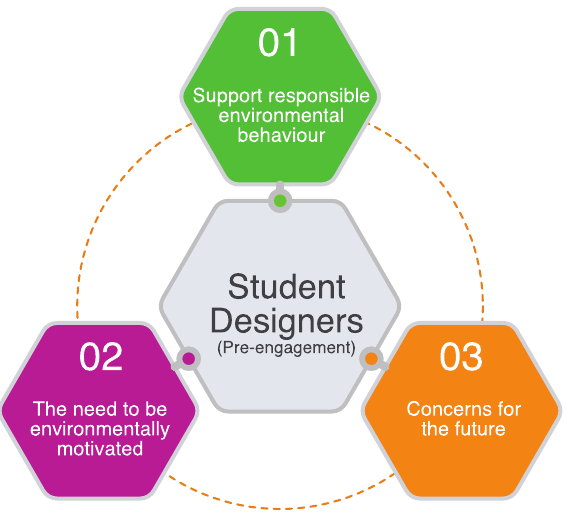
Figure 4. Final thematic map from the student designer pre‐engagement focus group